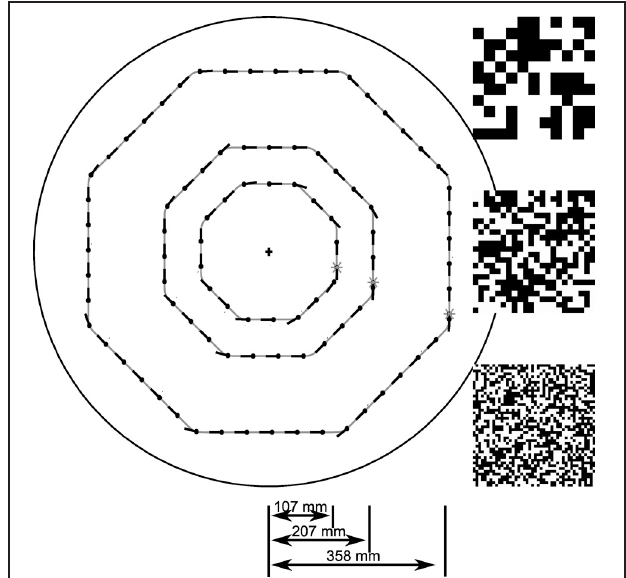
FIGURE 2 | Sketch of open-loop trajectories. Trajectories used to systematically investigate the texture dependence of the sensory module of the CyberFly. The intersaccadic segments pair-wise differ by a factor of two in duration. The outmost trajectory was used in electrophysiology. Random checker-board patches represent the textures used for model analysis: Large, medium, and small texture elements pair-wise differ by a factor of two in edge